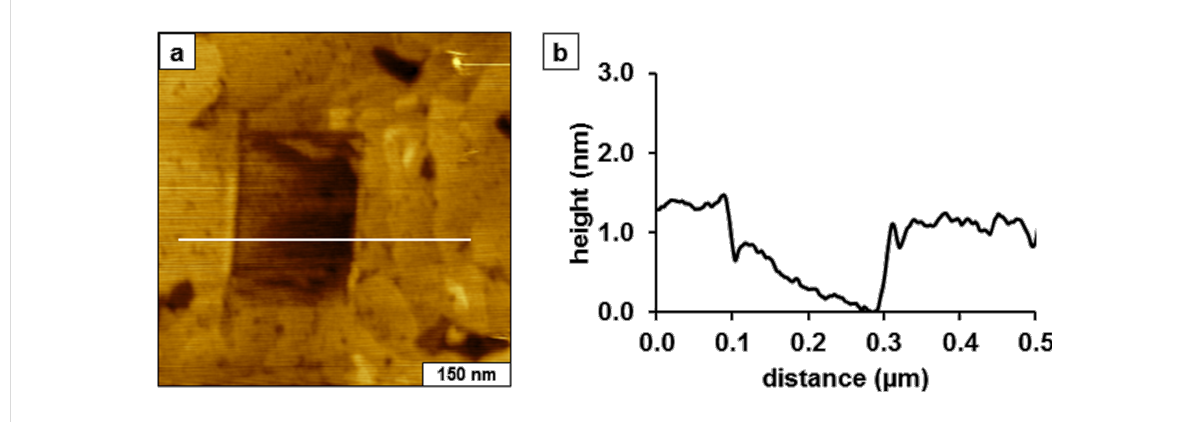
Figure 4: Nanoshaved square within a SAM of TMMH. (a) Topography image acquired in ethanol; (b) Line profile across the square pattern.